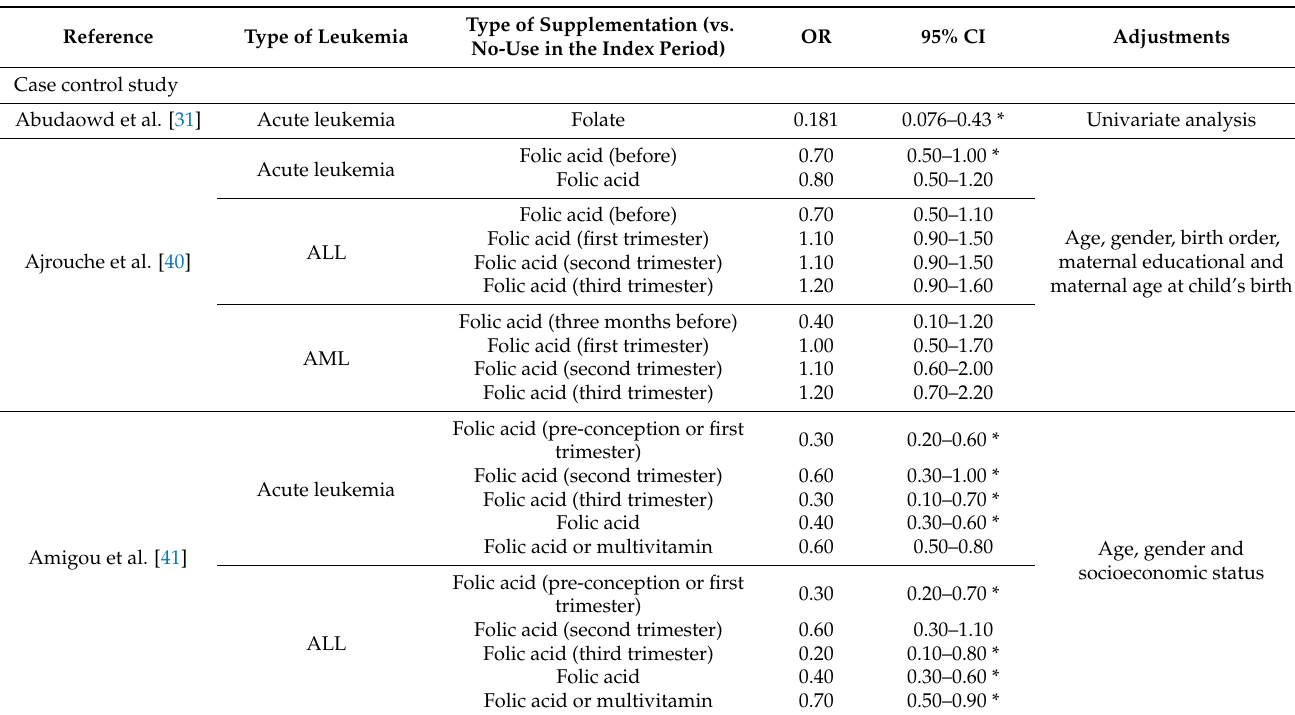
Table 10. Overview of the association between maternal supplement use during pregnancy (or period specified) and the risk of acute leukemia in